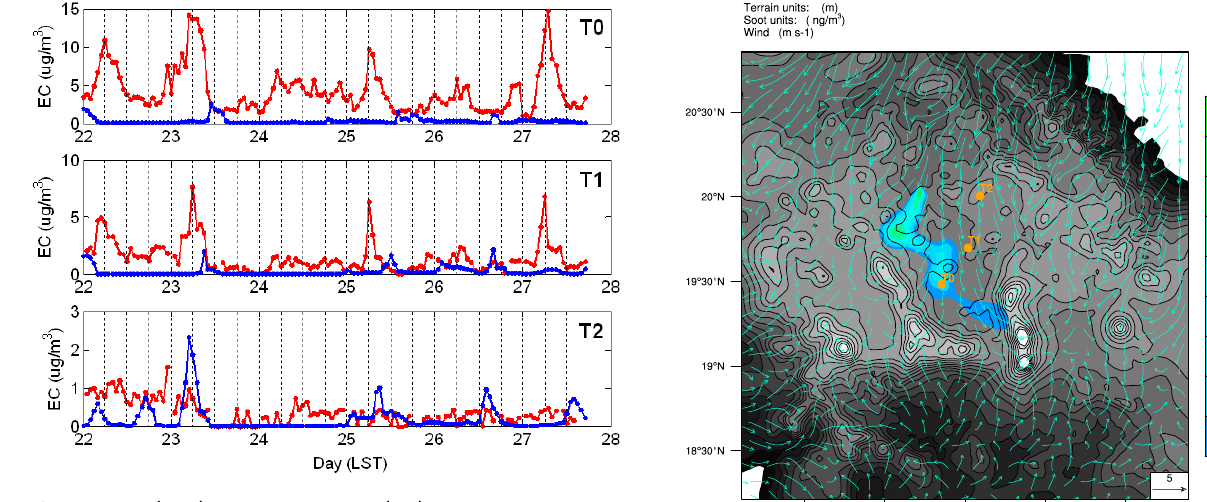
Fig. 5. Model (blue) and measurements (red) time series of EC con- centration for the simulation period. Results correspond to total TIC emissions (Power plant plus Refinery). T0 (upper panel); T1 (mid- dle panel) and T2 (bottom panel). Black dashed lines are plotted every 6h.